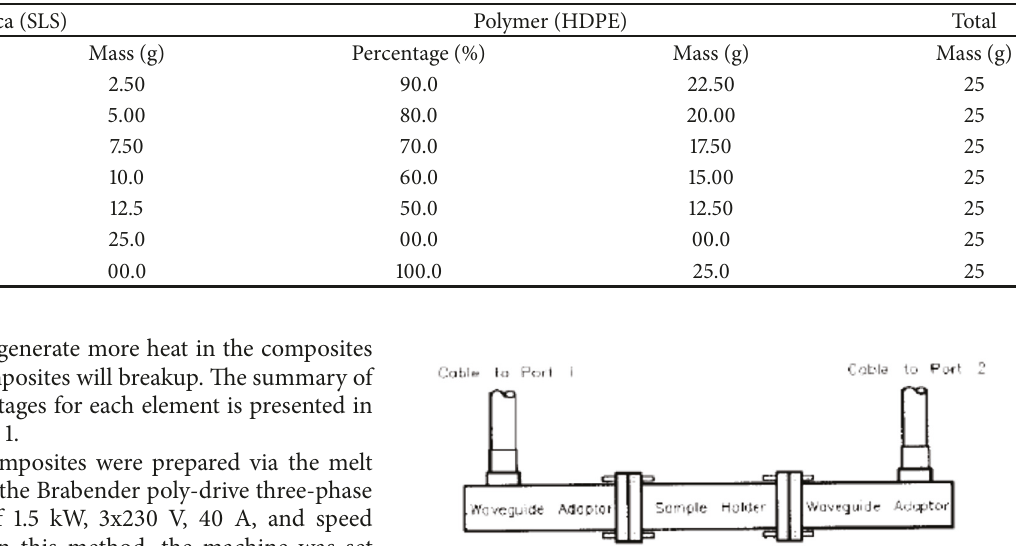
Table 1: Composition of raw materials used in composite preparation.